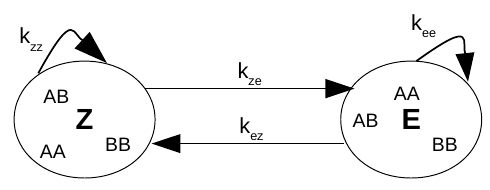
Scheme 4. Kinetic parameters for metathesis propagation